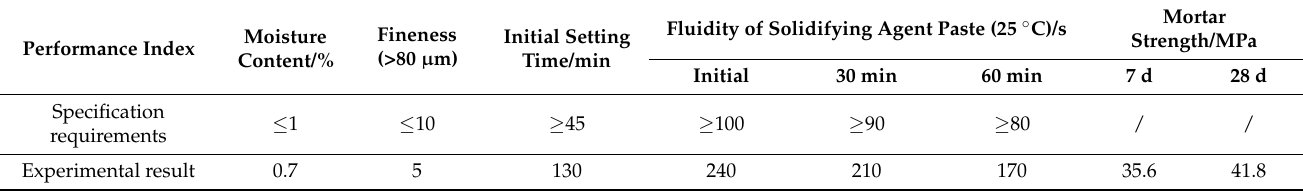
Table 1. Properties of soft soil solidifying agent.